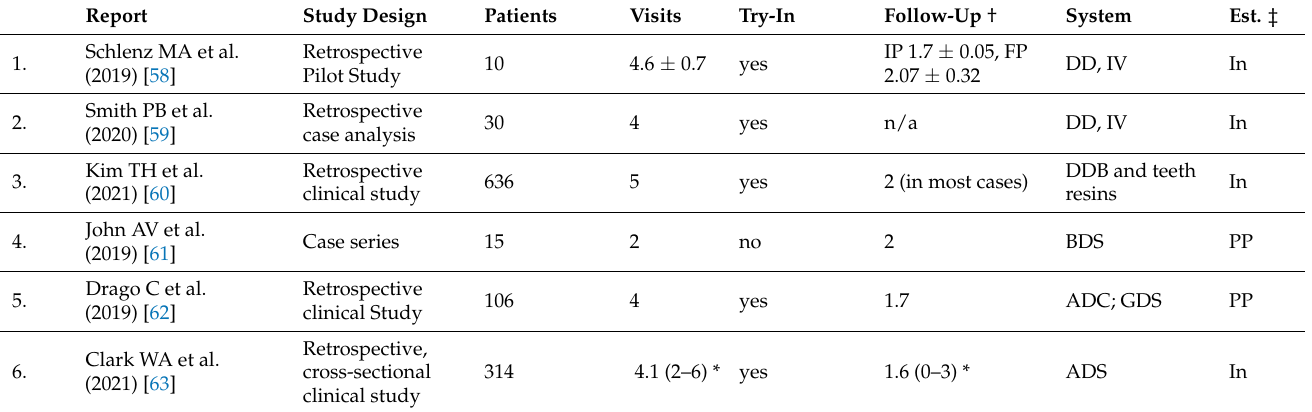
Table 1. Studies reporting treatments with Complete Denture implementing digital